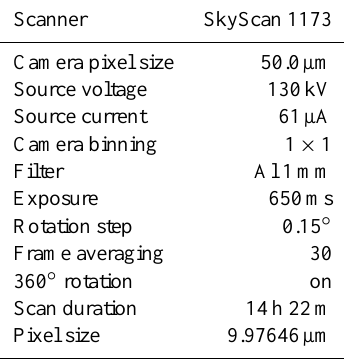
Table 1. Scanner setting data used for X-ray computed microto- mography